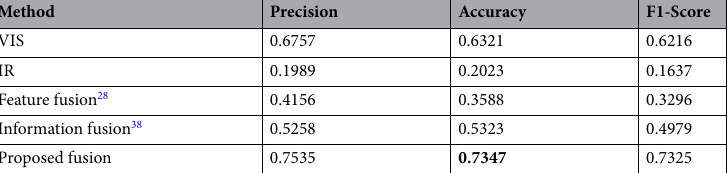
Method Precision